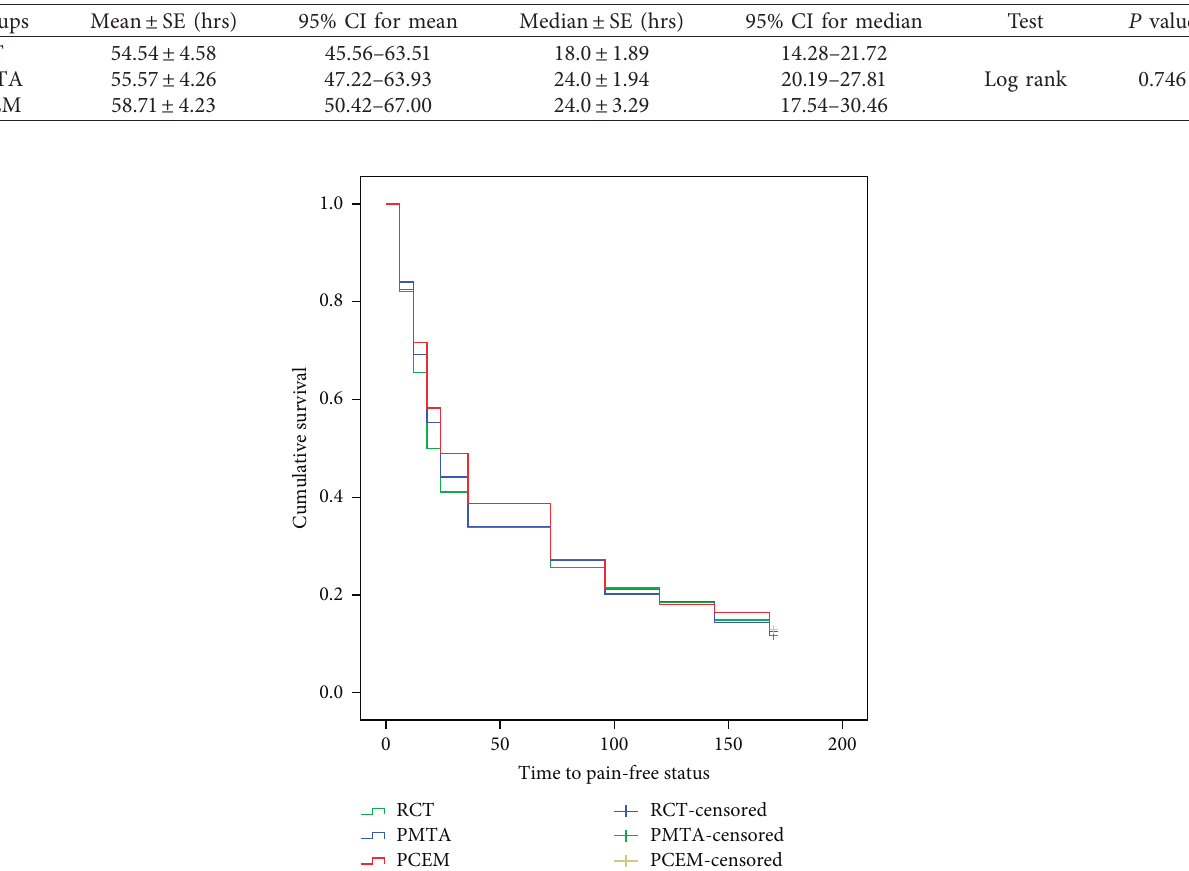
Figure 3: Time to pain-free status in the three study arms.